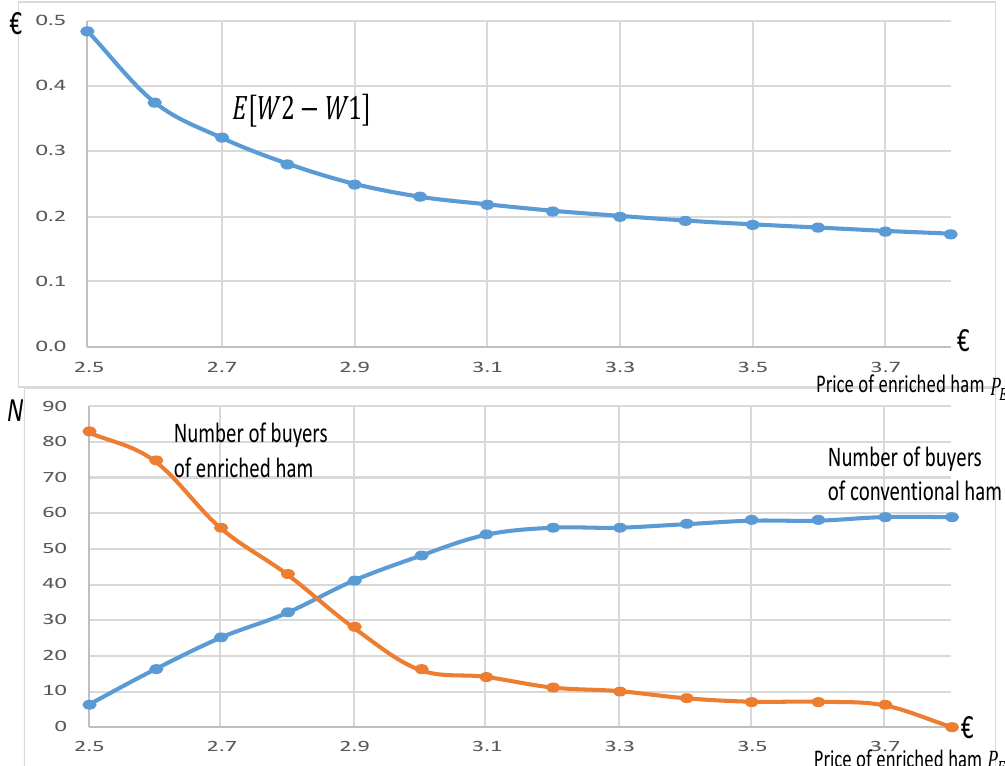
Figure 4. Average variations of consumers’ surpluses for one packet of enriched ham and the number of buyers following the introduction of enriched ham under perfect information.